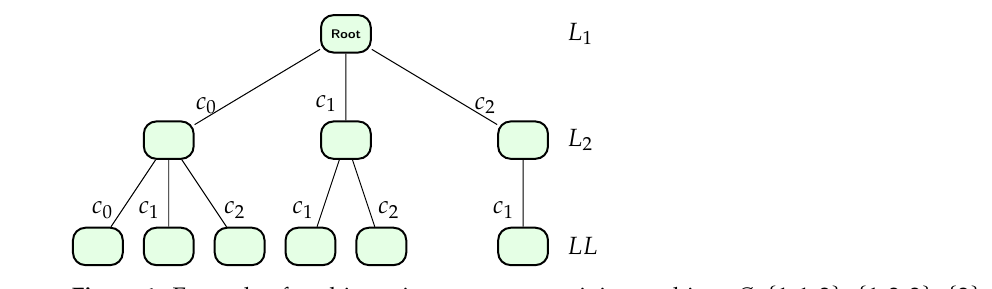
Figure 1. Example of multiset-trie structure containing multisets ∅ , { 1,1,2 } , { 1,2,2 } , { 2 } , { 1,2 } , { 2,2 } . The Null children are